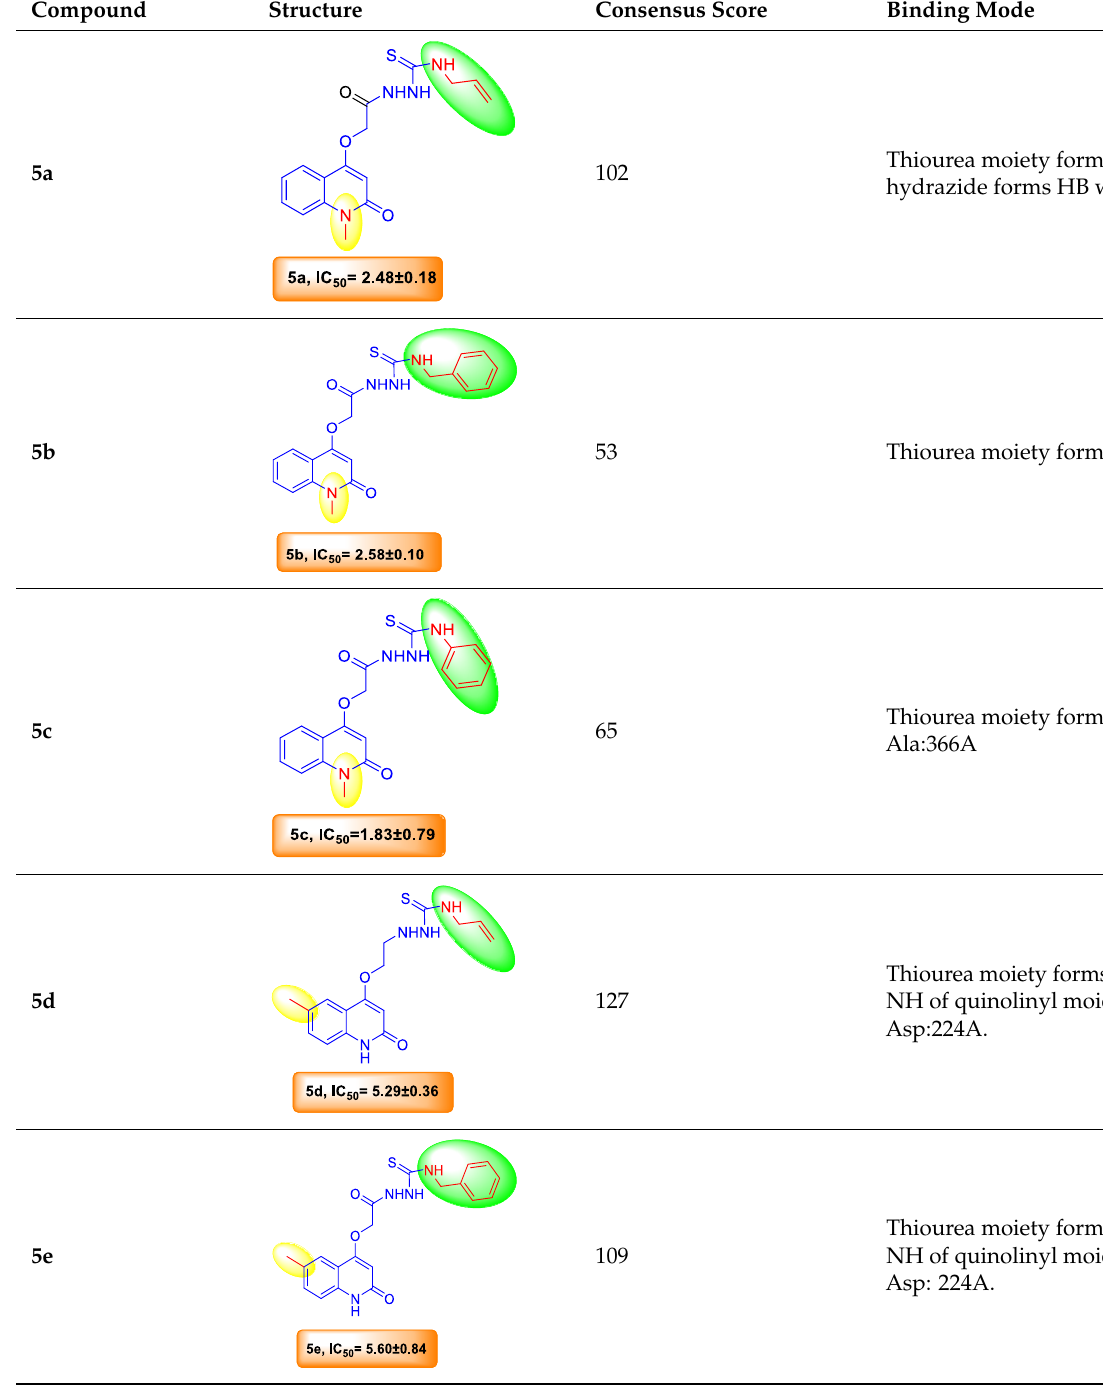
Figure 4. Visualization of compounds docking with PDBID: 4uBP: ( a ) compound 5c ; ( b ) compounds 5a and 5f ; ( c ) compounds 5b and 5a. Table 3. Docking mode and consensus scores for compound 5a – g . Compound Structure Consensus Score Binding Mode